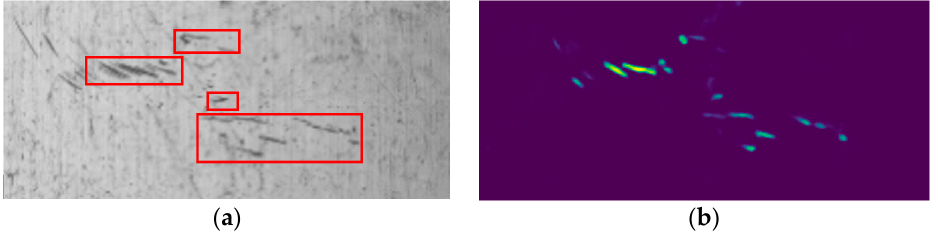
Figure 11. ( a ) Excerpt of a rolling element. Defects were manually highlighted with bounding boxes. ( b ) Segmentation image of the neural network before post-processing, displayed with viridis color scheme.